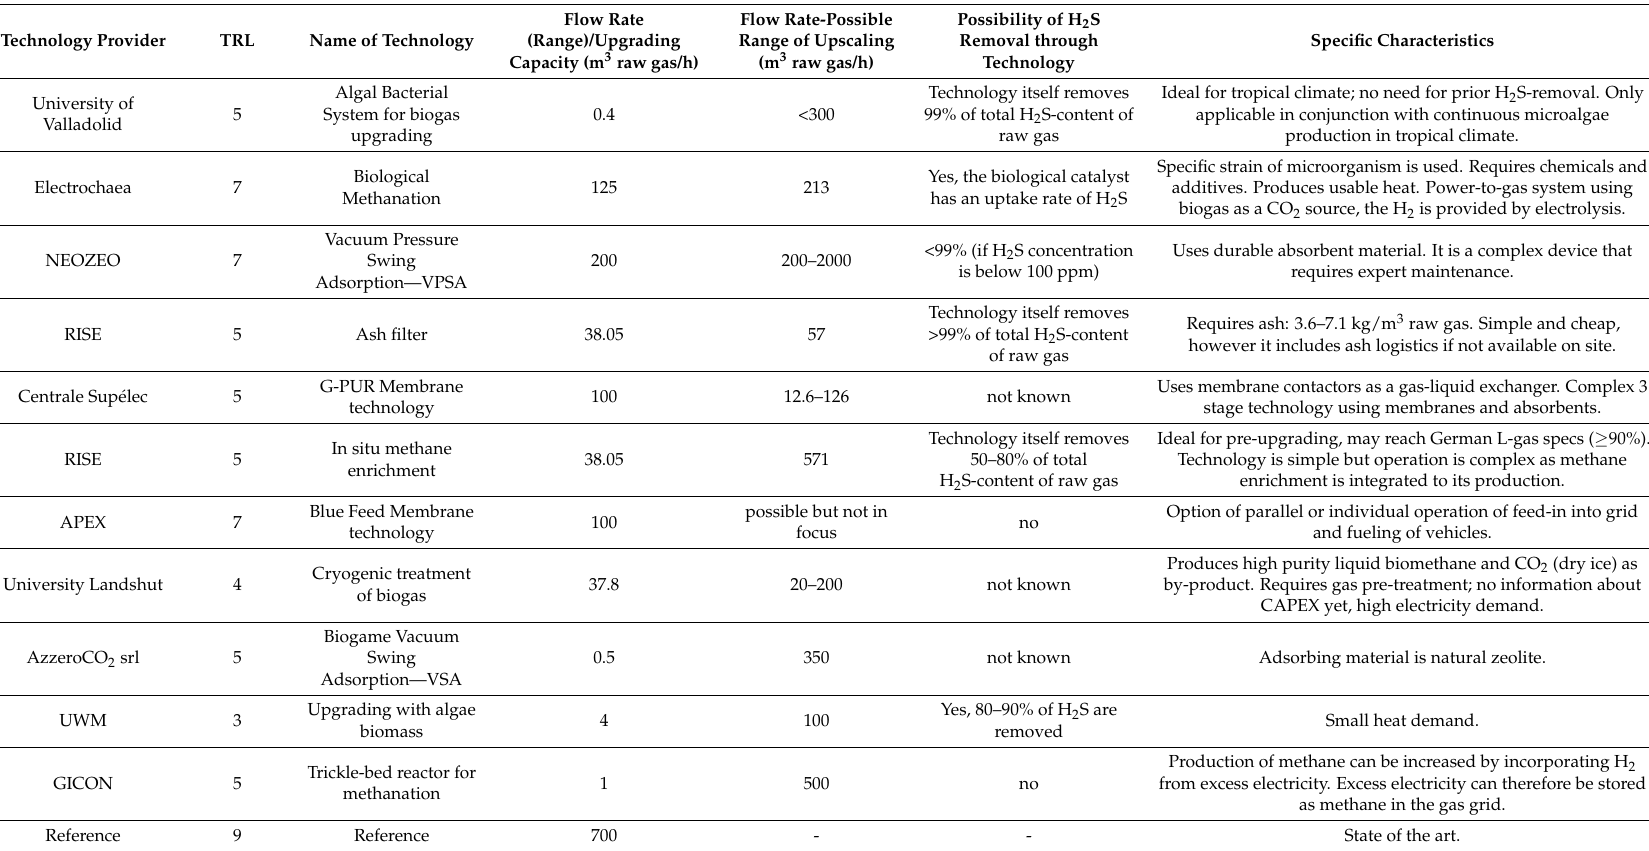
Table 5. Overview of selected data for biogas upgrading